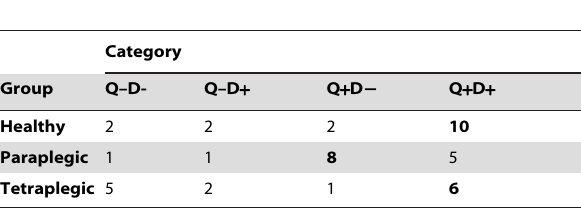
The category with the highest prevalence in each group is indicated in bold. doi:10.1371/journal.pone.0050757.t002 PLOS ONE |